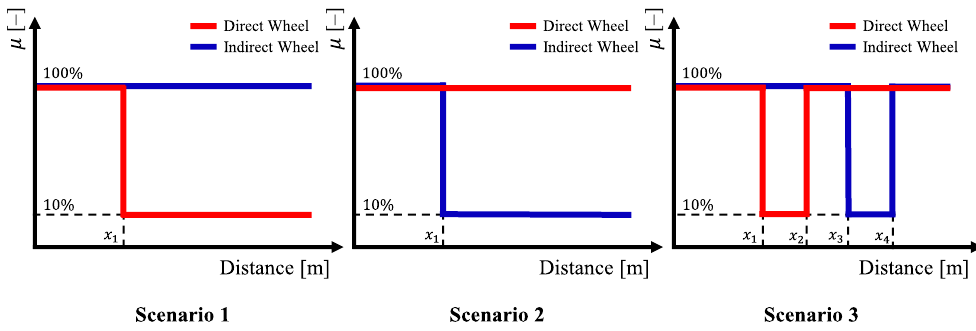
Figure 11. Wheel-rail contact friction configuration scenarios for SIMPACK